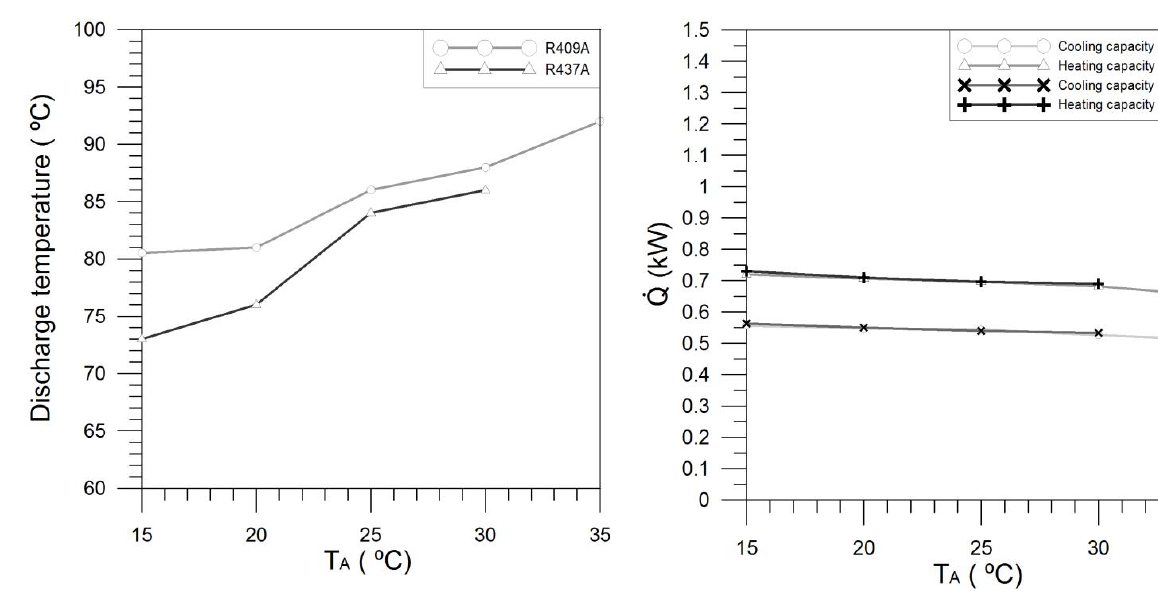
Figure 8: Effect of the heat source temperature on the cooling and heating capacities (Group A of tests).